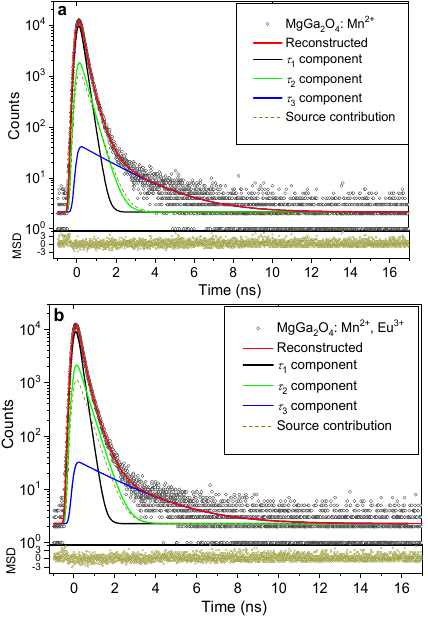
Fig. 4 Raw PAL spectra of spinel-structured (a) MgGa 2 O 4 :Mn 2+ and (b) MgGa 2 O 4 :Mn 2+ ,Eu 3+ ceramics, reconstructed from unconstrained x3-term fitting and source contribution (bottom insets show statistical scatter of